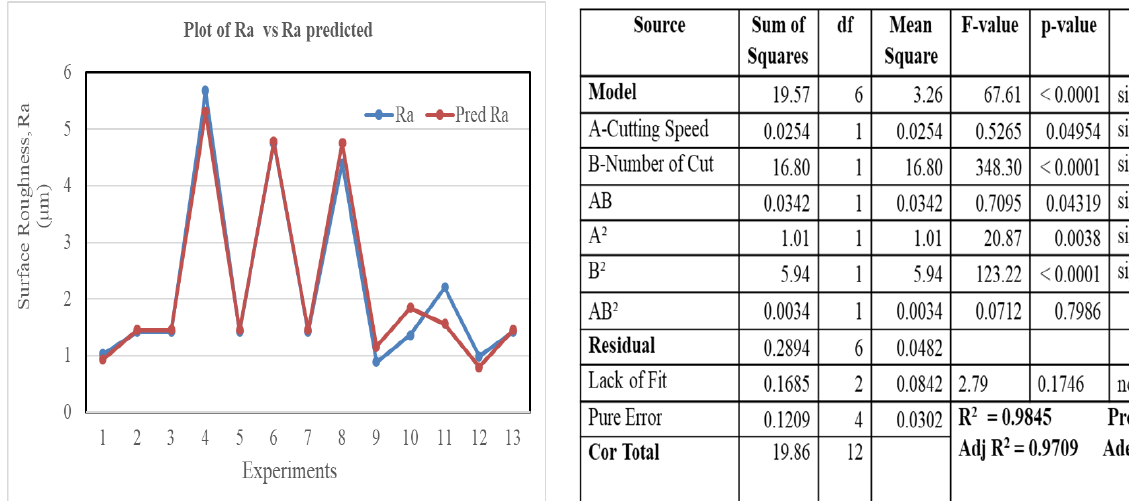
Figure 16. Plot of Ra vs predicted Ra, ANOVA model for Ti-6Al-7Nb.